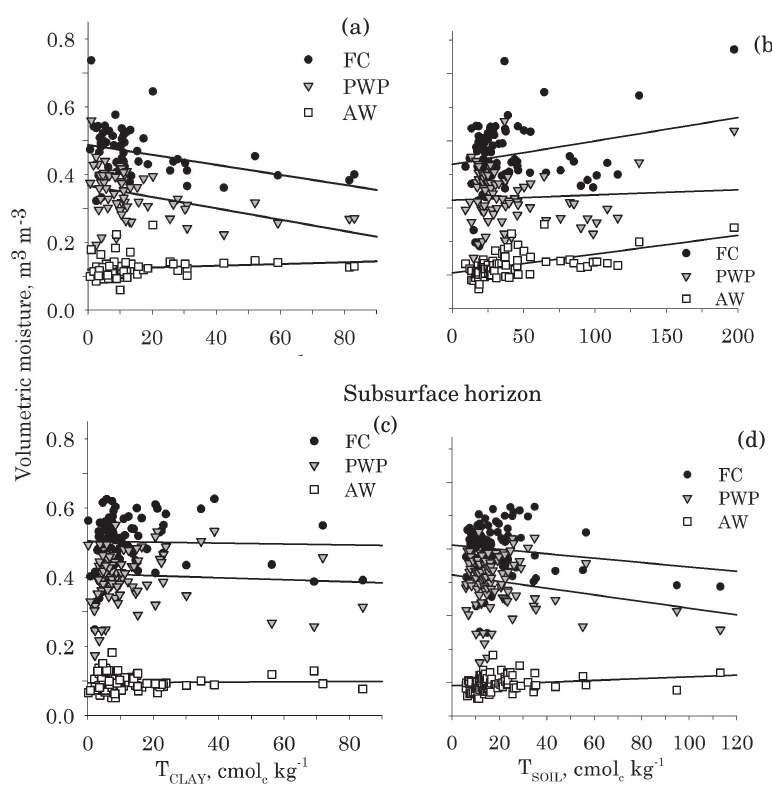
Figure 6. Scatter plots of field capacity (FC), permanent wilting point (PWP) and available water content (AW) versus activity of the clay fraction using two methods, one discouting the effect of organic matter on the CEC of the soil (T CLAY ) and the other disregarding this effect (T SOIL ), in surface (a, b) and subsurface (c, d) horizons in soils of the State of Santa